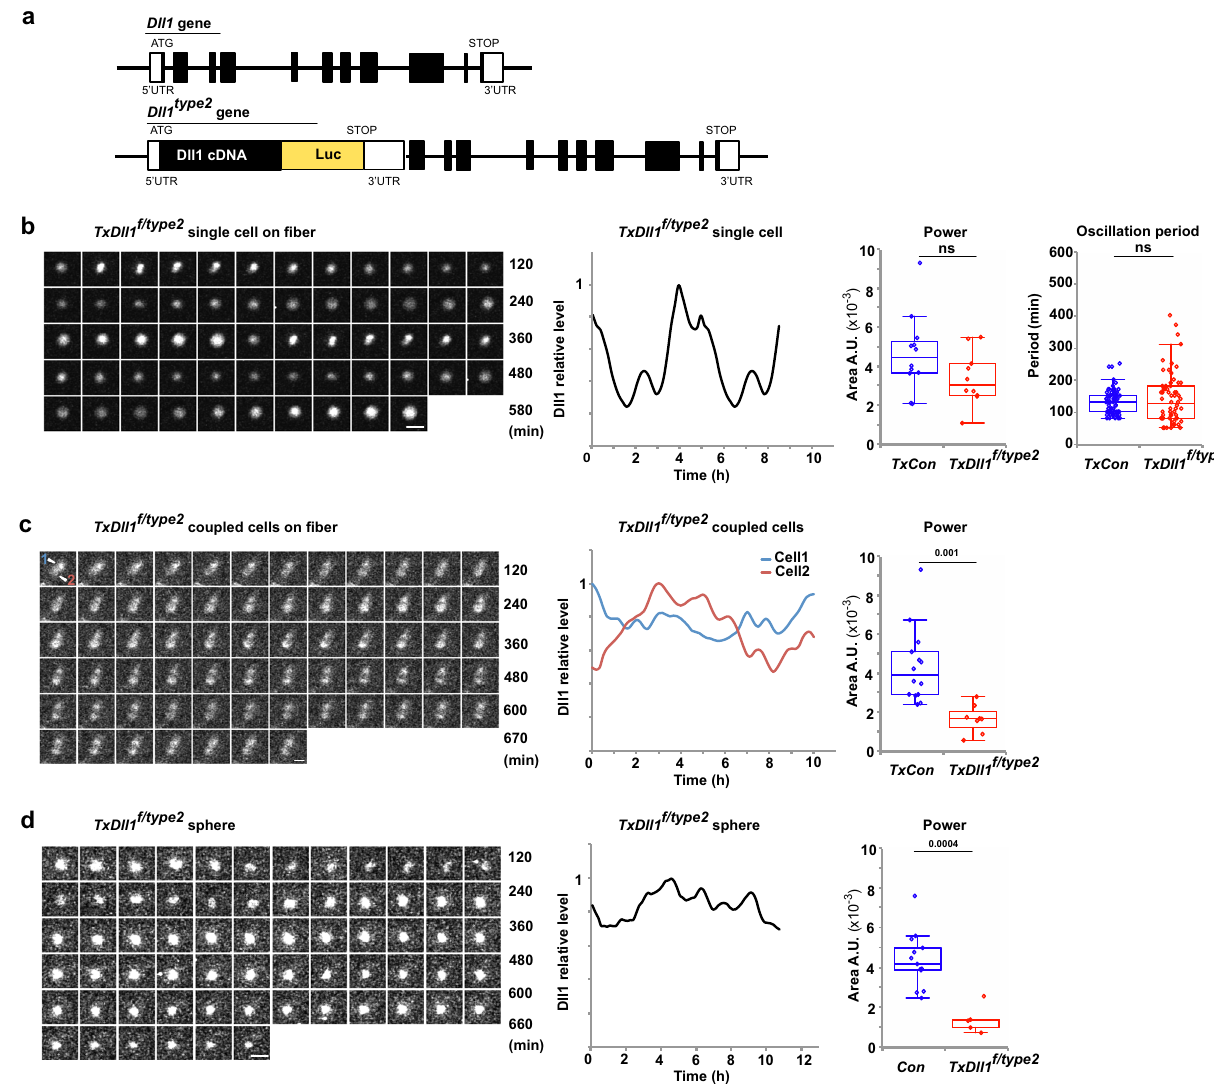
Fig. 6 The Dll1 type2 mutation interferes with oscillatory Dll1 expression. a Schematic display of Dll1 gene and the Dll1 type2 mutant allele; in Dll1 type2 a fused cDNA encoding Dll1 (black) and fi re fl y luciferase (luc, yellow) were inserted into the Dll1 locus; the 5 ′ and 3 ′ UTR, a translational stop codon (Stop), and the initiation codon (ATG) are indicated. b Bioluminescence images observed in a single Dll1 type2 mutant muscle stem cell associated with a myo fi ber and quanti fi cation of this bioluminescence signal (left); the fi ber and associated stem cell were obtained from a TxDll1 f/type2 animal. Quanti fi cation of the oscillatory stability (power of the Fast Fourier transformation) and the oscillatory period of luciferase bioluminescence in control and Dll1 type2 mutant cells (right); n = 10 experiments. c Bioluminescence images observed in two Dll1 type2 mutant muscle stem cells contacting each other on a cultured myo fi ber and quanti fi cation of the bioluminescence signals in each of the two cells (left; signals from cell 1 and 2 are shown in blue and red, respectively). Quanti fi cation of the oscillatory stability (power of the Fast Fourier transformation) of luciferase bioluminescence in coupled control and Dll1 type2 mutant cells (right); n = 4 experiments. d NanoLuc bioluminescence signals and quanti fi cation of these signals in a cell located in a sphere of Dll1 type2 mutant cells (left); one cell co- transfected with an nGFP and EpDll1-NanoLuc expression plasmid was monitored. Quanti fi cation of the oscillatory stability (power of the Fast Fourier transformation) in sphere cultures of Dll1 type2 mutant cells (right); n = 5 experiments. In the box plot, center lines show the medians; box limits indicate the 25th and 75th percentiles; whiskers extend 1.5 times the interquartile range. Scale bars, 15 μ m. Exact p values are indicated, ns indicates P > 0.05, unpaired two-sided t coupled muscle stem cells during muscle regeneration depends on the oscillatory input of the Dll1 signal, and that the mere presence of Dll1 does not suf fi ce to ensure the correct balance.